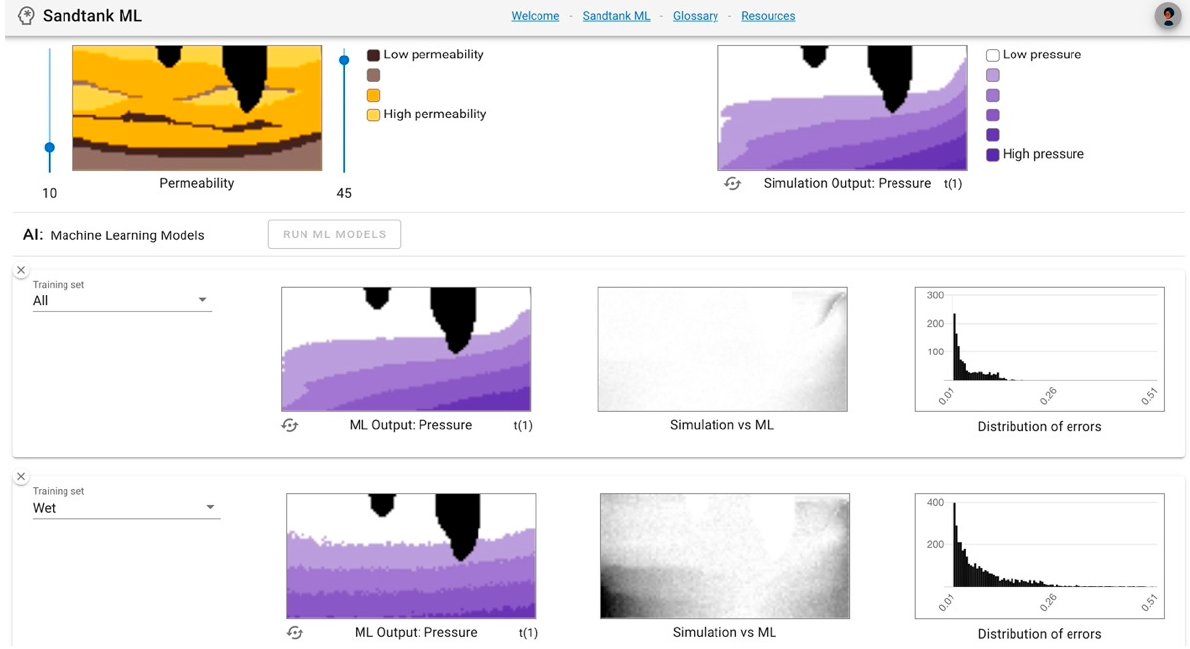
Figure 11. Sandtank-ML display for user example 2 showing the boundary condition inputs, pressure simulation output, and the associated ML pressure outputs using and wet training datasets.